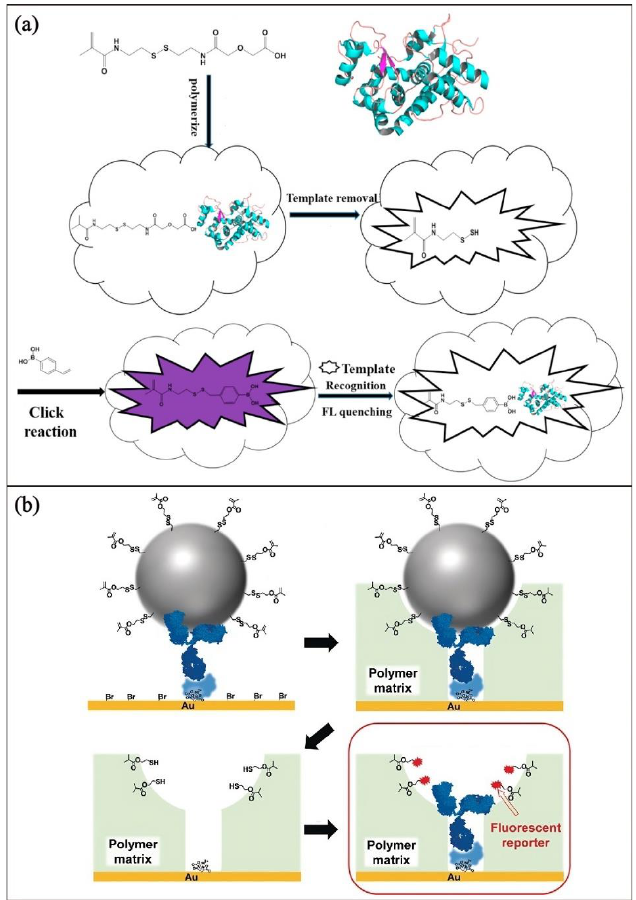
Figure 4. Schematic illustration of the preparation of ( a ) luminescent protein imprinted polymer for glycoprotein detection. Adapted with permission [66]. Copyright 2017, Elsevier. ( b ) Fluorescent sensing platform for exosome detection. Adapted with permission [67]. Copyright 2019, Wiley-VCH.